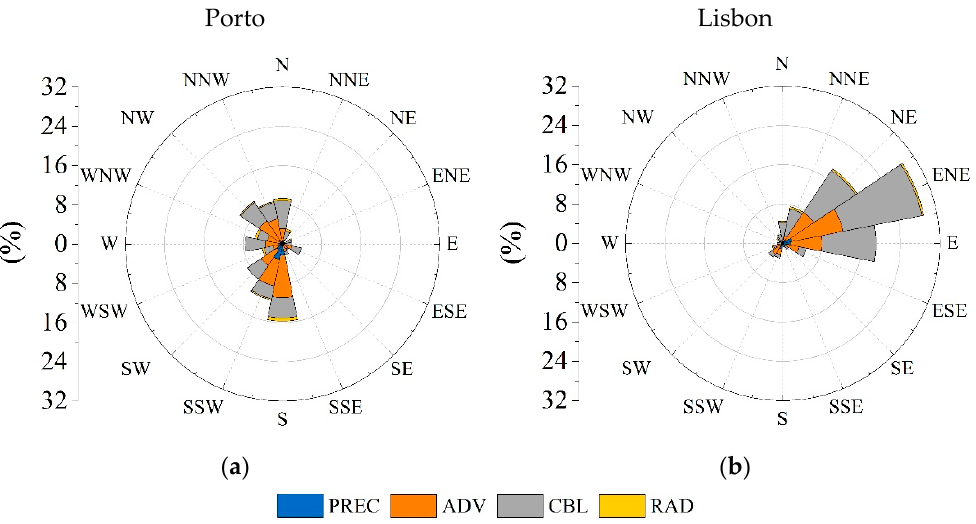
Figure 10. Wind roses associated to fog types’ relative frequency at Porto ( a ) and Lisbon ( b ).